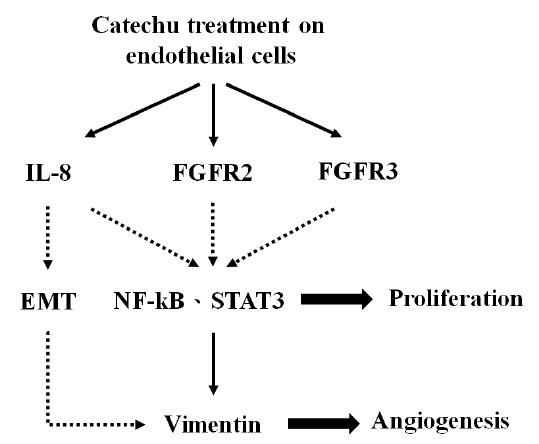
Figure 5. Summary of the possible mechanism underlying the angiogenic effect of catechu extracts in HMEC1 cells.